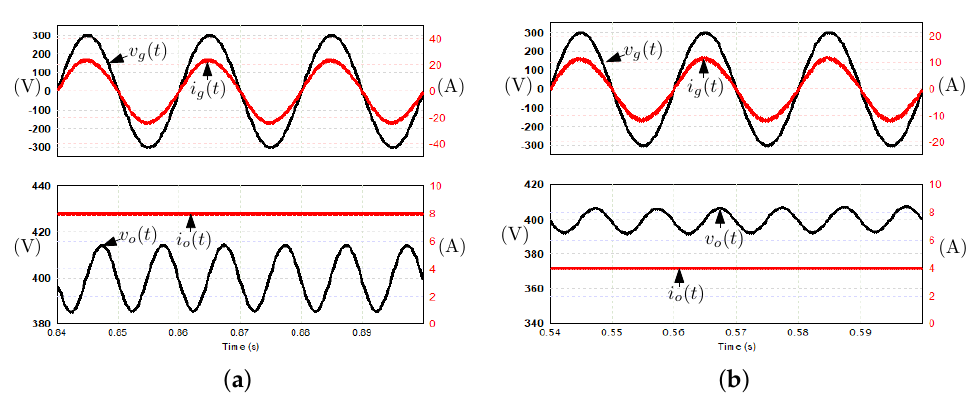
Figure 19. Steady state waveforms for boost mode of input voltage v g ( t ) , input current i L 1 ( t ) , output voltage v o ( t ) and the output current i o ( t ) with: ( a ) Full power. ( b ) Half